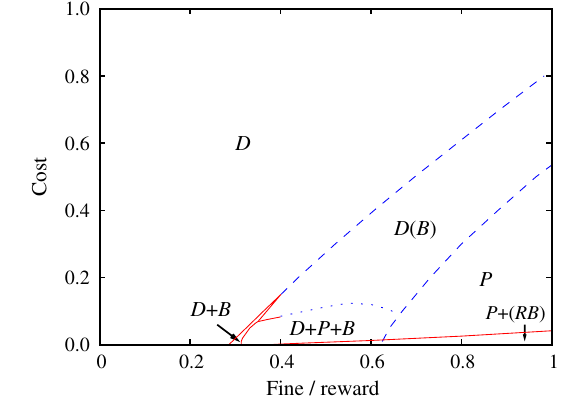
FIG. 5. Full (cid:1) (cid:1) (cid:2) phase diagram, as obtained for r ¼ 2 : 5 . Solid red lines denote continuous phase transitions, while dashed blue lines denote discontinuous phase transitions. More pre- cisely, the dashed blue line between phases D and D ð B Þ indicates that there would be a discontinuous phase transition if only D and B strategies were initially present in the system. (In other words, the frontier of dominance between strategies D and B is delineated.) The same holds for the dashed blue line separating phases D ð B Þ and P . The three-strategy D þ P þ B phase is separated with a dotted blue line to emphasize that there are two very different ways in which this solution can give way to the D ð B Þ phase. In particular, at smaller fines, the transition is continuous because the average fraction of strategy P gradually decays to zero (see Fig. 6 for a quantitative insight). At larger fines, however, the averages of all three strategies remain finite, but the amplitude of oscillations diverges regardless of the system size (see Fig. 8 for details), which ultimately results in an abrupt termination of cyclic dominance between the three strategies (see Fig. 7). The notation of the P þ ð RB Þ phase at the lower right corner of the phase diagram has the same meaning as described in the caption of Fig. 1.